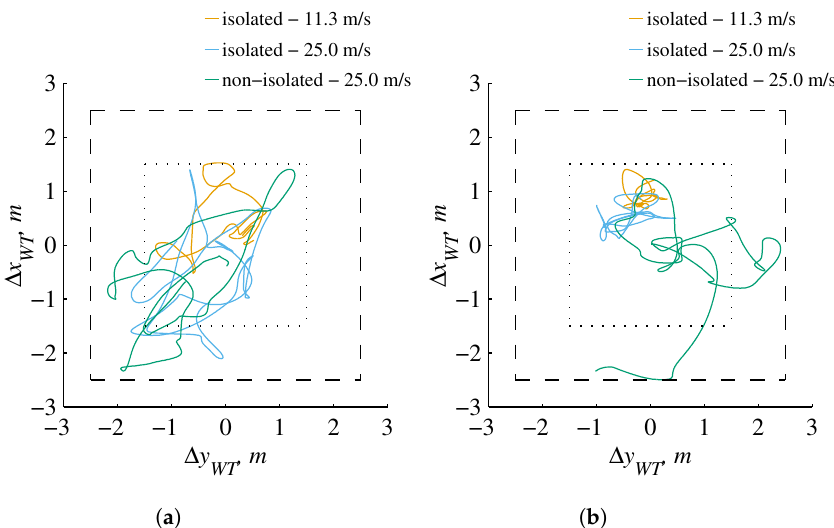
Figure 24. Longitudinal ∆ x and lateral ∆ y position of the helicopter winch above the WT nacelle (Pilot A). ( a ) Helicopter with bare-airframe response type (BA). ( b ) Helicopter with attitude-command attitude-hold response type